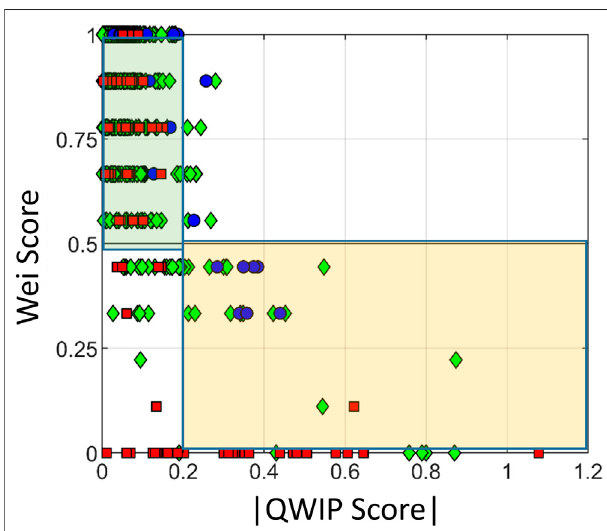
FIGURE 8 | Comparisons of the absolute value of the QWIP score with the spectralquality score proposed byWei et al.(2016) ( “ Wei score ” ). AQWIP threshold of > 0.2 and aWei score of < 0.5 were considered failing spectra and viceversa.Coloredboxeshighlightwherebothapproachespass(green) and fail (yellow) data. Water types include: Blue-green (blue circles), Green (green diamonds) and Brown (red squares) following from Figure 2 .